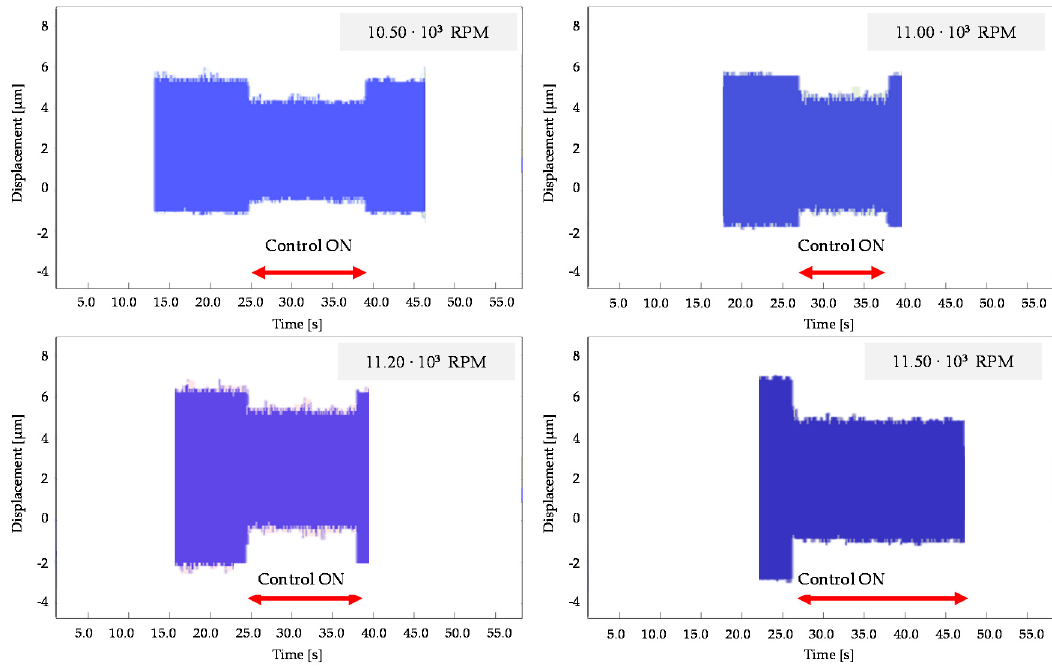
Figure 9. Experimental test of unbalanced spindle at different speeds considering on/off control.